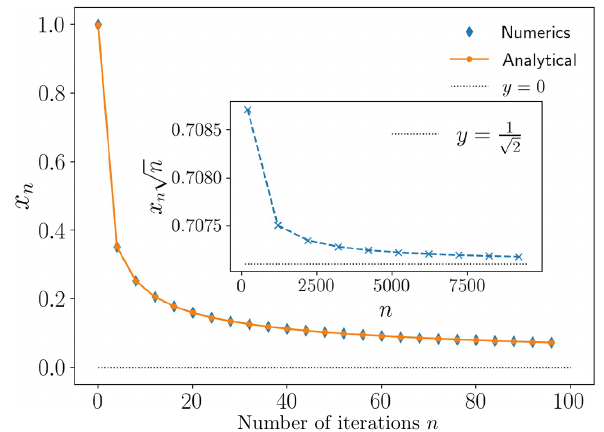
FIG. 15. The SWAP-CNOT edge: convergence to the respective fixed point y ∗ = 0 under the map initiated with c ( 0 ) = π/ 16. The inset shows the power-law behavior for the same initial condition √ √ n → as seen from the convergence y n n → 1 for large n